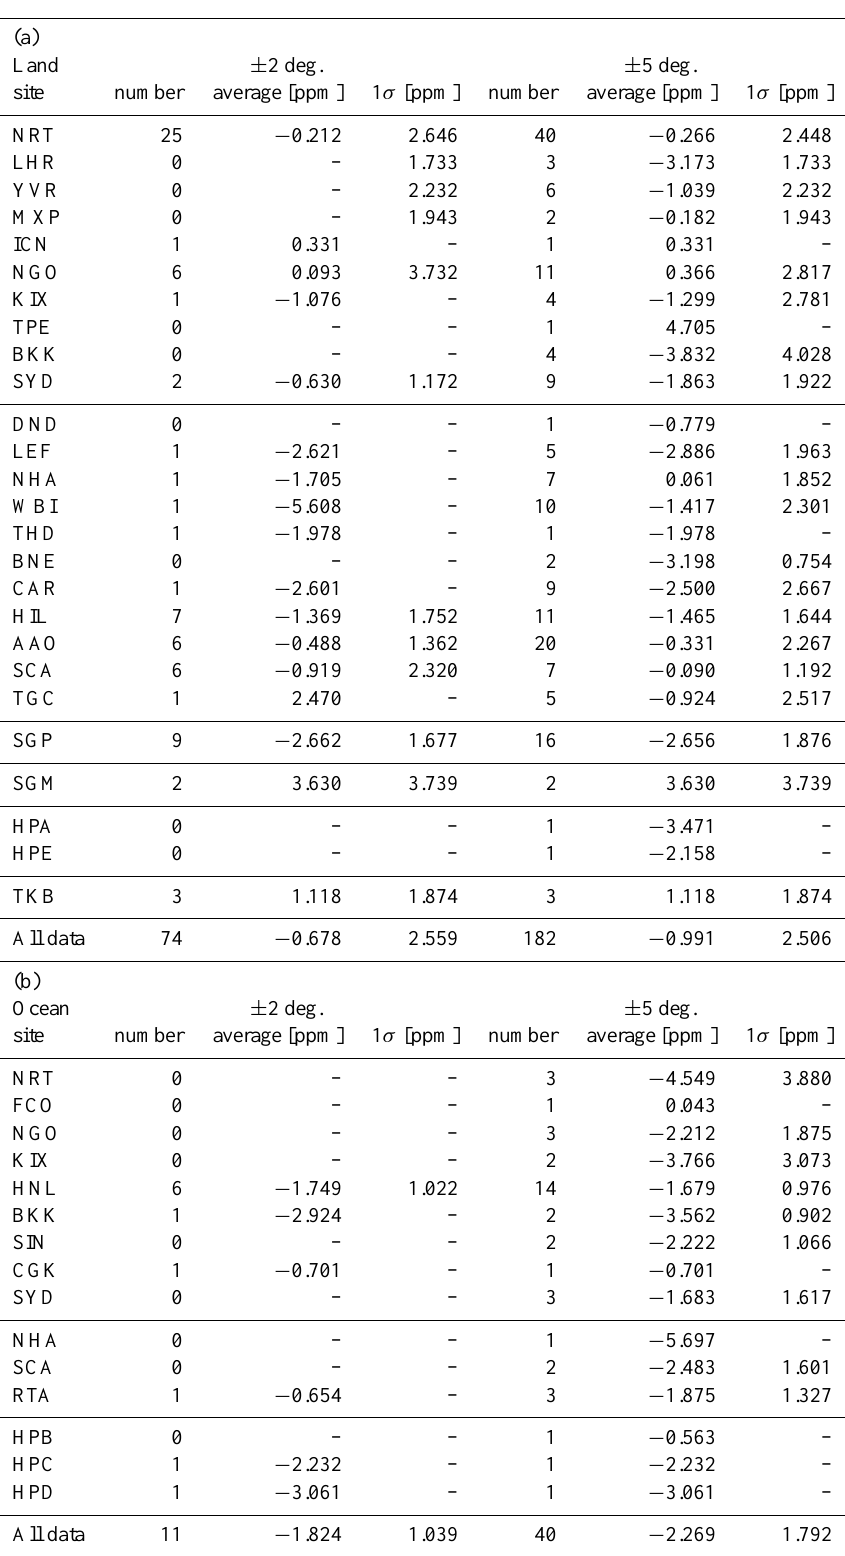
Table 4. The average and 1 standard deviation (1 σ ) of the differences between GOSAT XCO 2 and aircraft-based XCO 2 at each site. The GOSAT data were retrieved over (a) land and (b) ocean regions within ± 2 and ± 5 ◦ latitude/longitude boxes centered at each aircraft observation